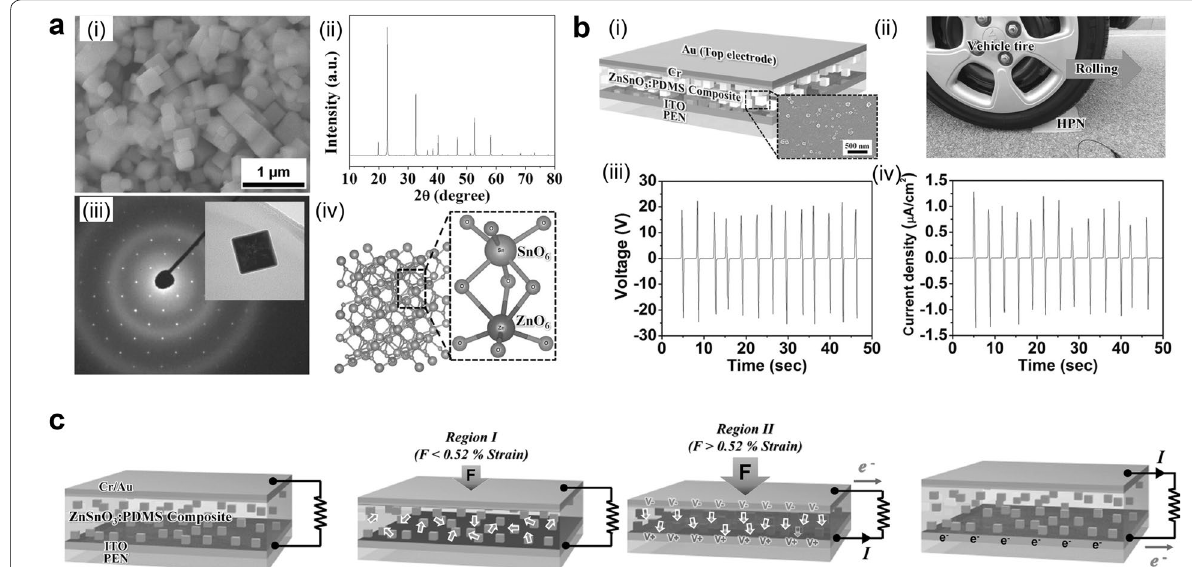
Fig. 3 a SEM image of ZnSnO 3 nanocubes and crystal structure characterization using XRD and SAED pattern. b Schematic structure of composite based PENG and output performance by vertical stress using vehicle. c Working mechanism of charge induction by stress‑induced poling effect (Reproduced from [20] with copyright permission from 2014 John Wiley &